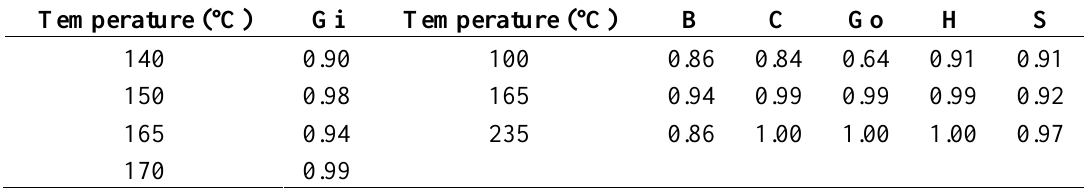
Table 3. Coefficients of determination ( r 2 ) for Sharp-Hancock lines of best fit (ln(−ln(1 − α)) vs. ln( t )) to mineral transformations in bauxite residue. Mineral names are abbreviated as